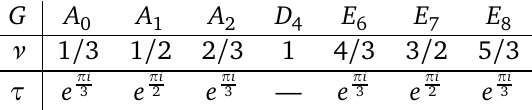
Table 1: Basic data for the 4d SCFTs probing F-theory singularities. The